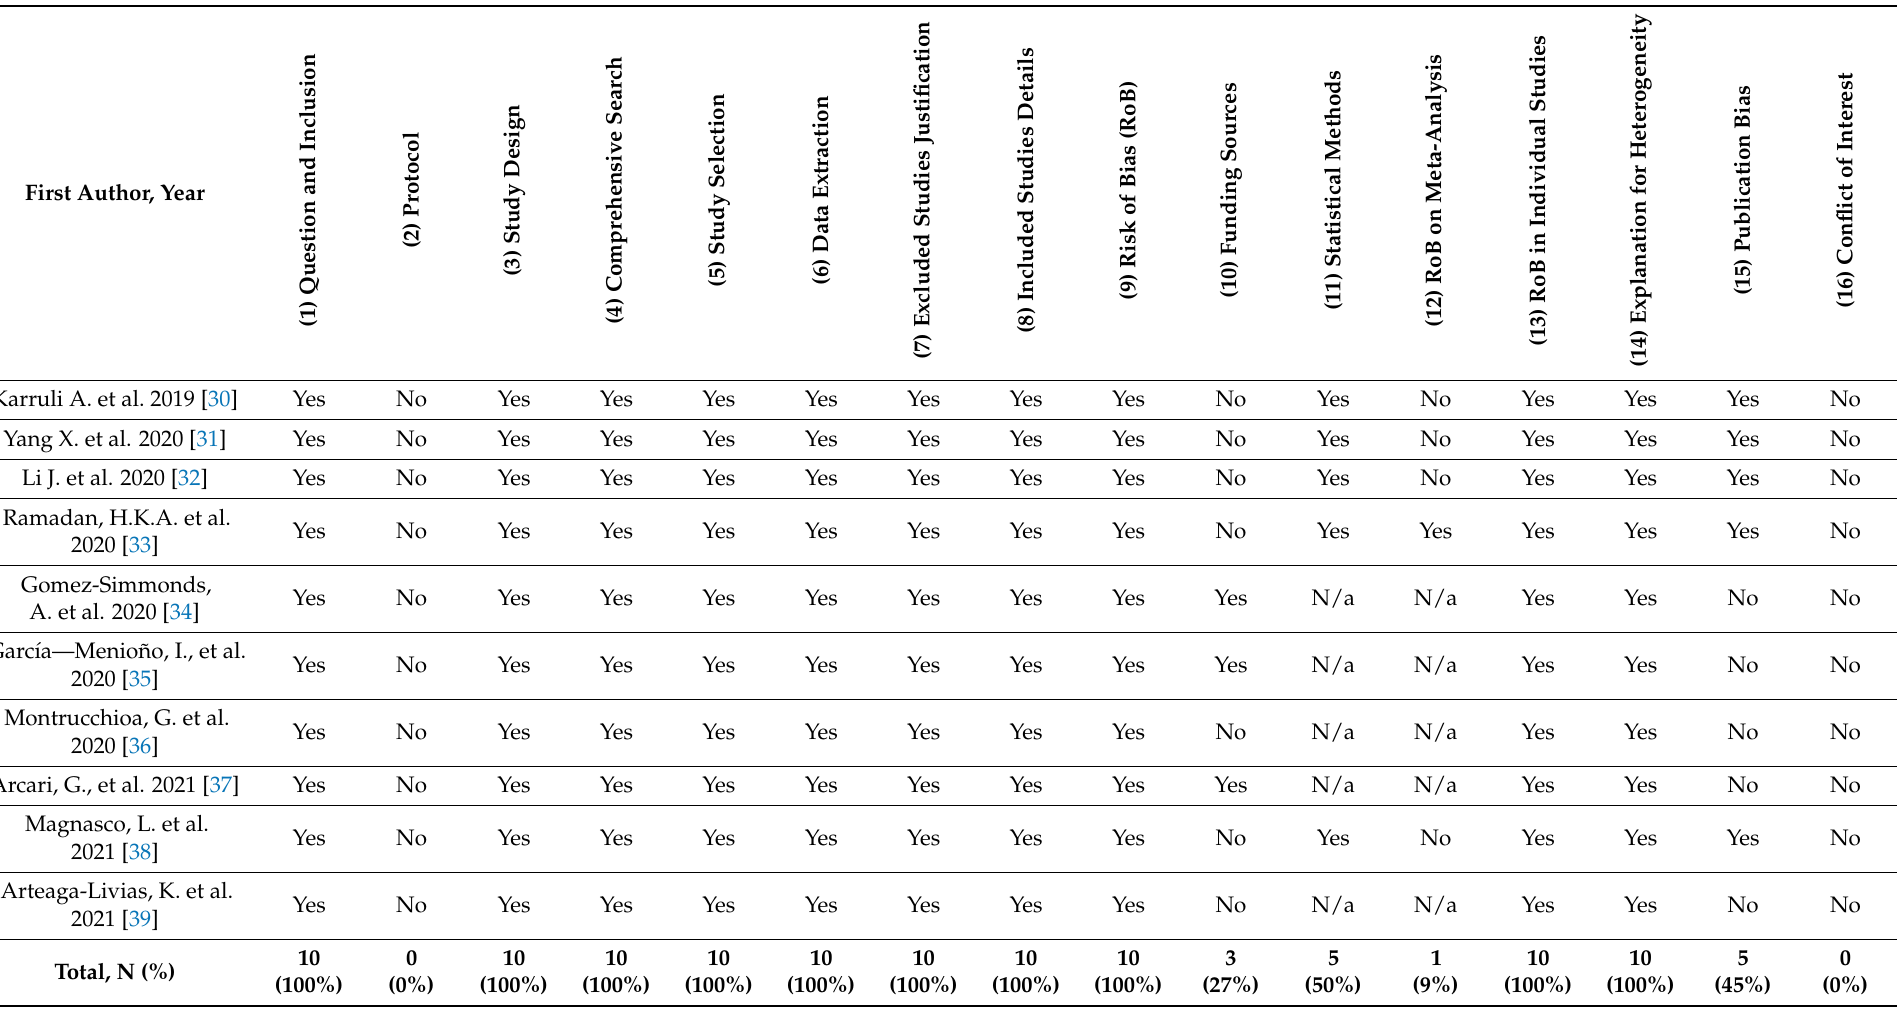
Table 3. Summary of the AMSTAR 2 quality